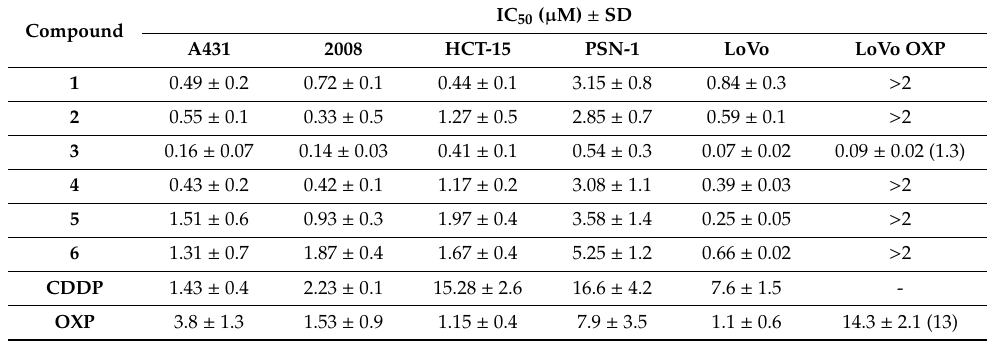
Table 5. Cytotoxic activity in vitro evaluated by MTT test at 72 h. IC 50 values were calculated with a four-parameters logistic model ( p < 0.05). CDDP: cisplatin, OXP: oxaliplatin. IC 50 ( µ M) ± SD Compound A431 2008 HCT-15 PSN-1 LoVo LoVo OXP 0.49 ±